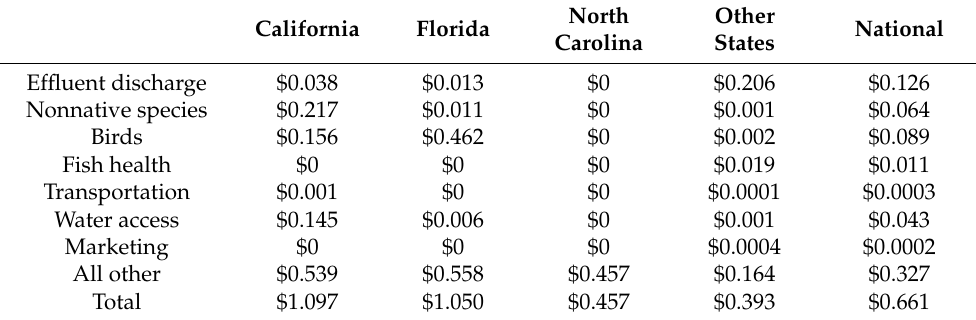
Table 10. Total regulatory cost by regulatory category by state ($/kg, mean of total production).